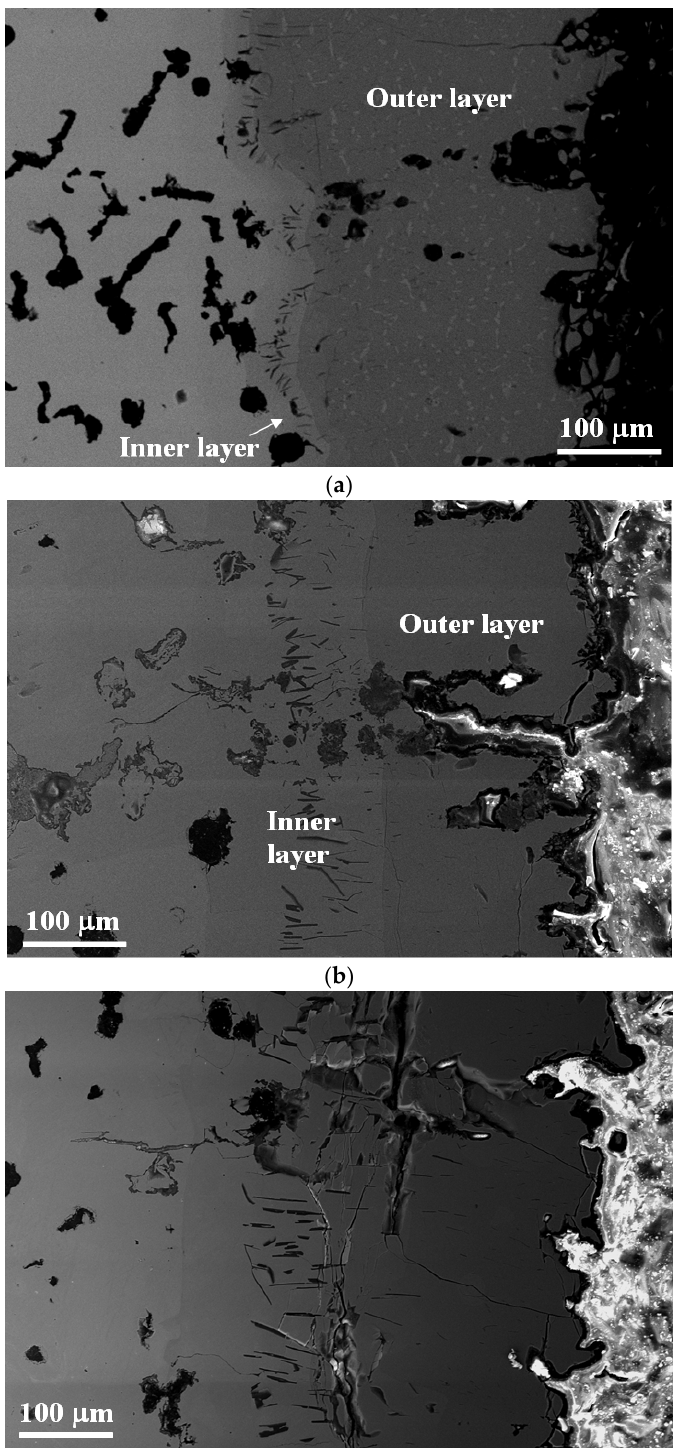
Figure 6. SEM cross-sections of the aluminide-coated cast iron ( a ) before oxidation, ( b ) after cyclic oxidation in N 2 –12O 2 at 850 °C for 14 cycles, and ( c ) after cyclic oxidation in N 2 –12O 2 –10H 2 O at 850 °C for 14 cycles. To characterise the outer sub-layer, the XRD technique was applied on the surface of the sample giving the pattern (a) shown in Figure 7. It can be seen that the major peaks observed were Fe 2 Al 5 .